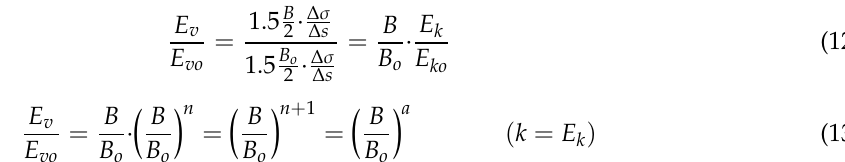
Table 7. Scale-effect comparison between the plate loading and repetitive plate-loading tests.